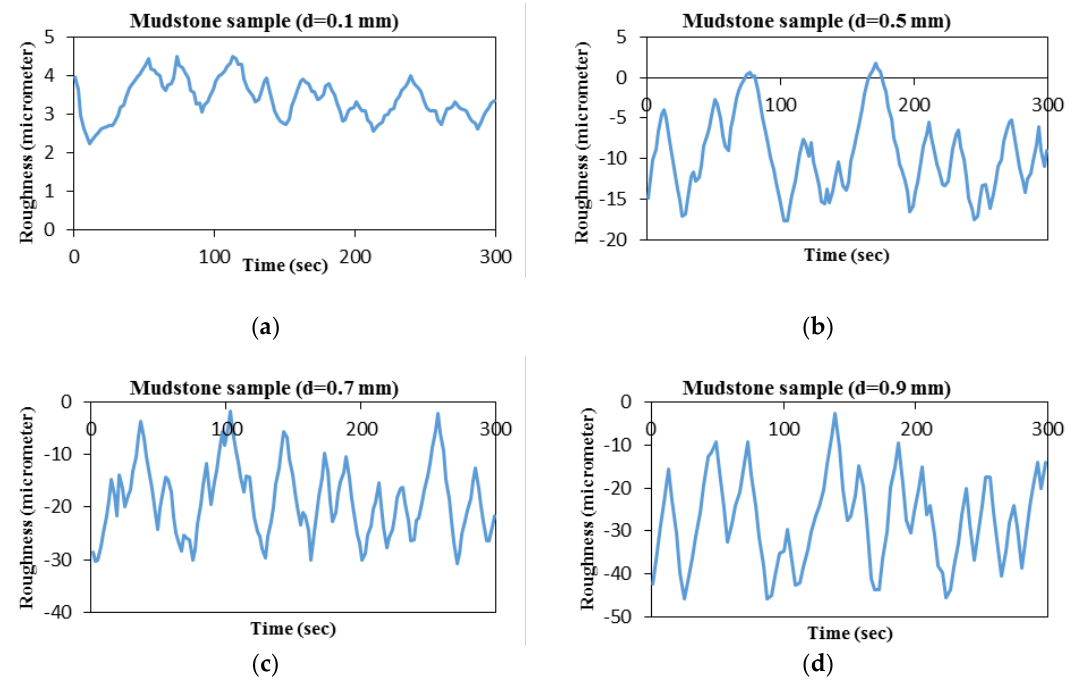
the mudstone cutting test.